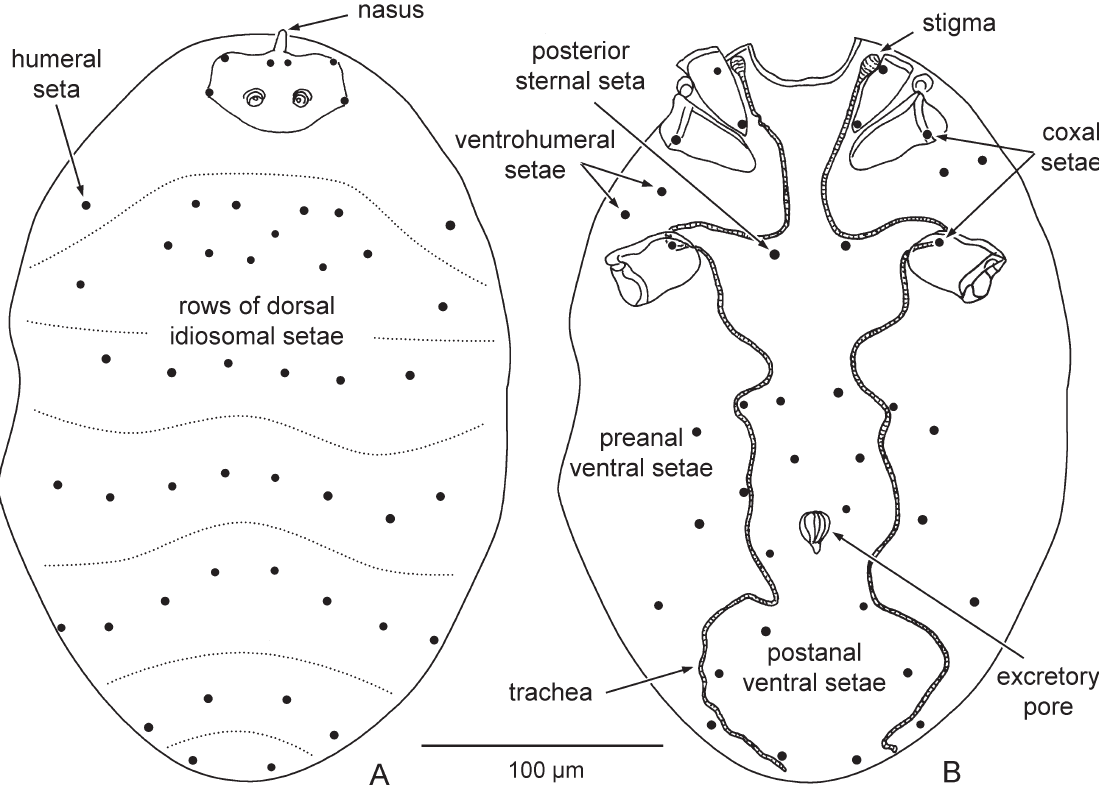
Fig. 2. Idiosoma of Leeuwenhoekiinae Womersley, 1944. A . Dorsal aspect. B . Ventral